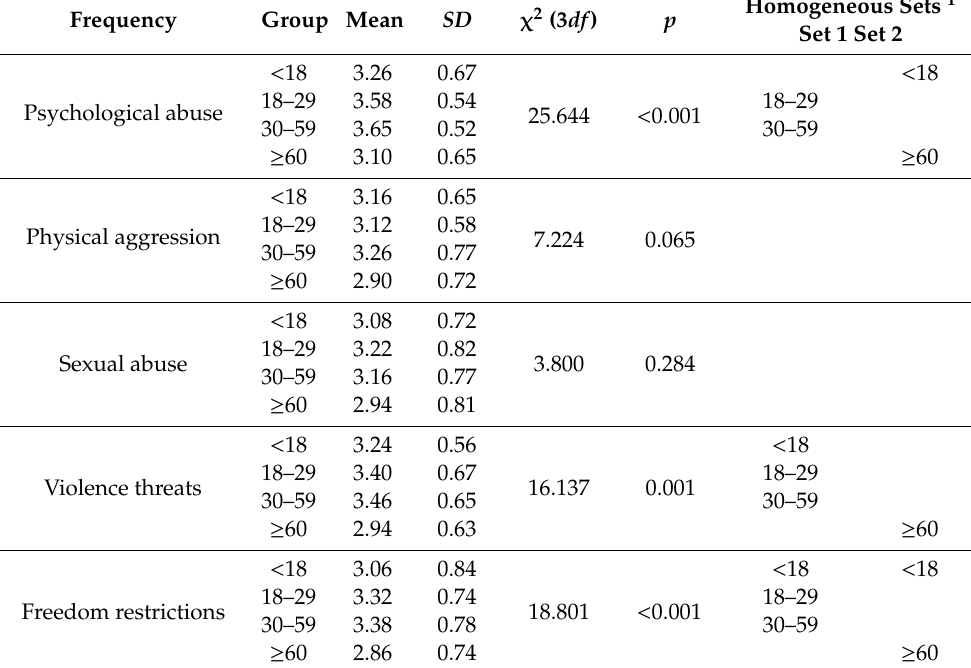
Table 5. Perceived frequency of IPVAW types: mean di ff erences among age